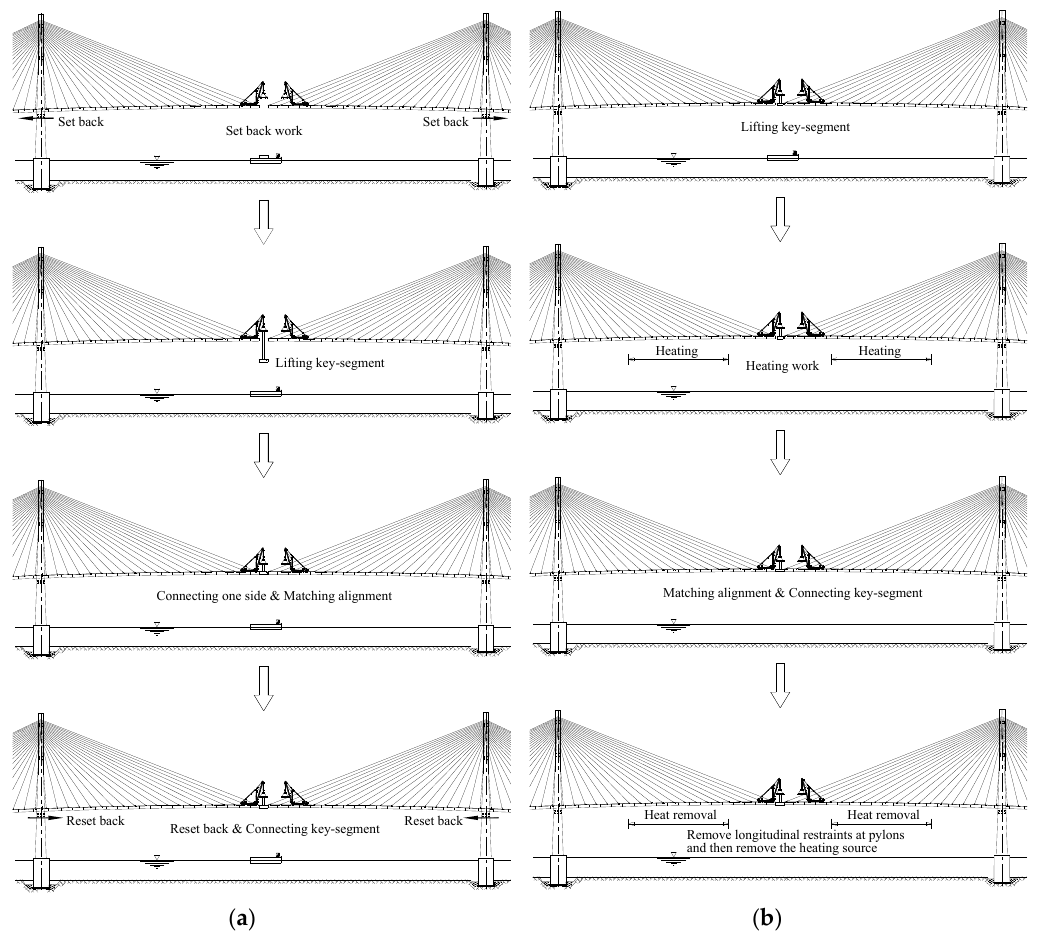
Figure 3. Comparison of key segment closing methods. ( a ) Conventional set back and reset back method; ( b ) new key segment closing method based on thermal prestressing.